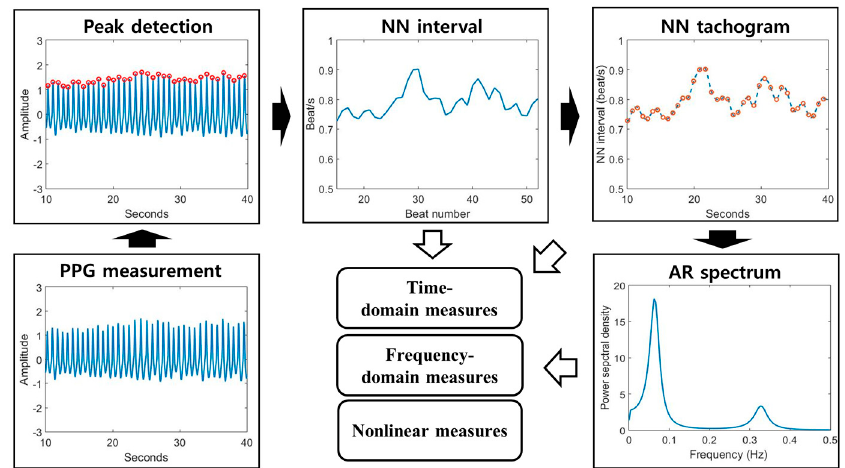
Figure 2. Block diagram of HRV analysis. The HRV analysis procedure includes the following steps: PPG measurement, peak detection, NN interval calculation, NN tachogram estimation, and autoregressive (AR) spectrum analysis. After these steps, we finally obtain the time, frequency, and non-linear features.